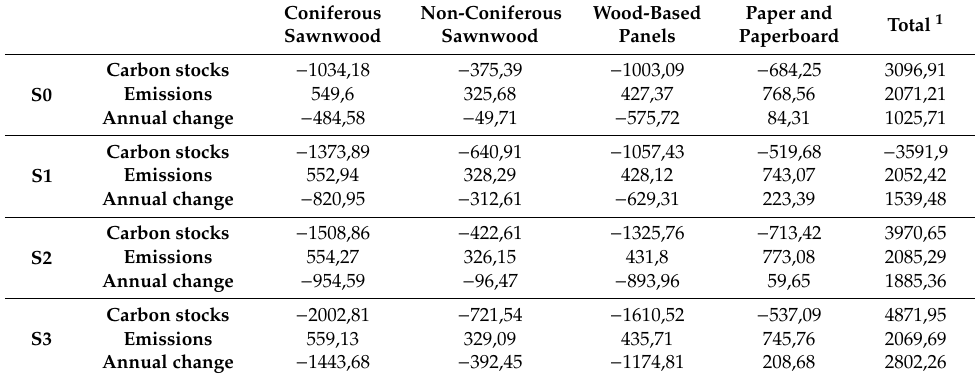
Coniferous Non-Coniferous Wood-Based Paper and Total 1 Sawnwood Sawnwood Panels Paperboard − 1034,18 −